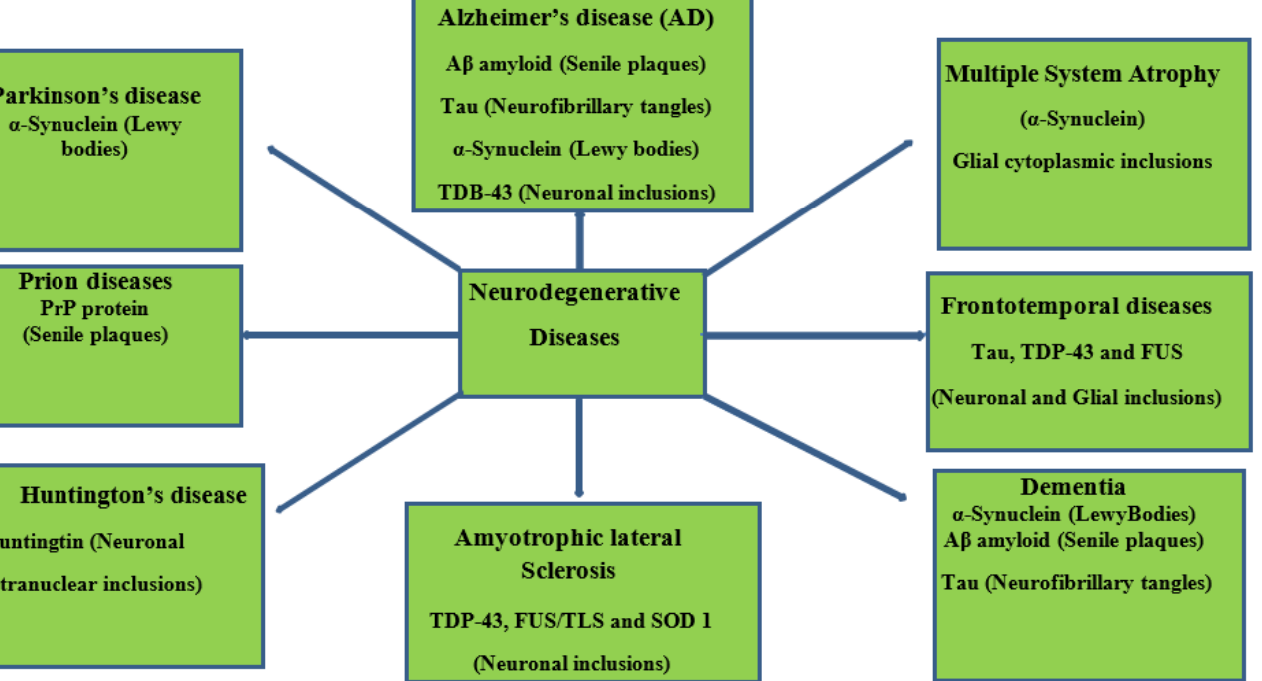
Figure 1. Schematic representation of neurodegenerative diseases, their pathology, and target proteins.